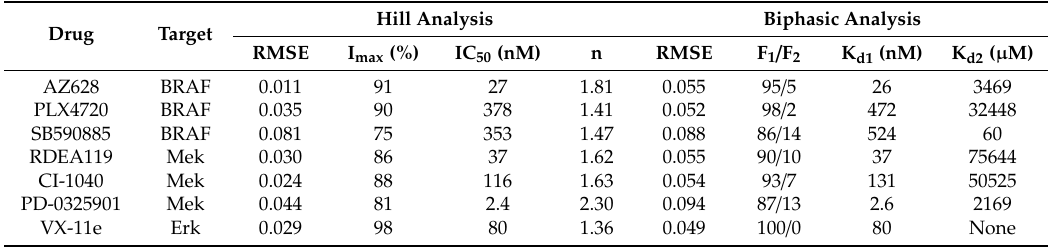
Table 3. Analysis of DU-4475 cell line responses to BRAF, Mek, and Erk kinase inhibitors by the Hill equation and the biphasic mathematical model. The data used for the analyses are from the Genomics of Drug Sensitivity in Cancers database (Supplementary Data for Table